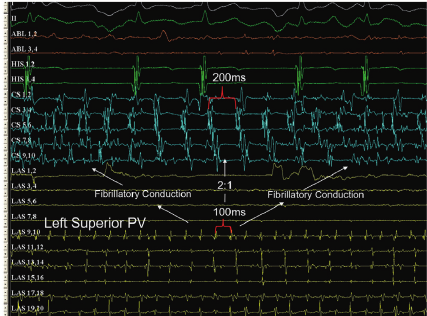
Figure 7: Focal automatic firing (cycle length: 100ms) from LSPV enters the LA either by 2:1 conduction or by fibrillatory